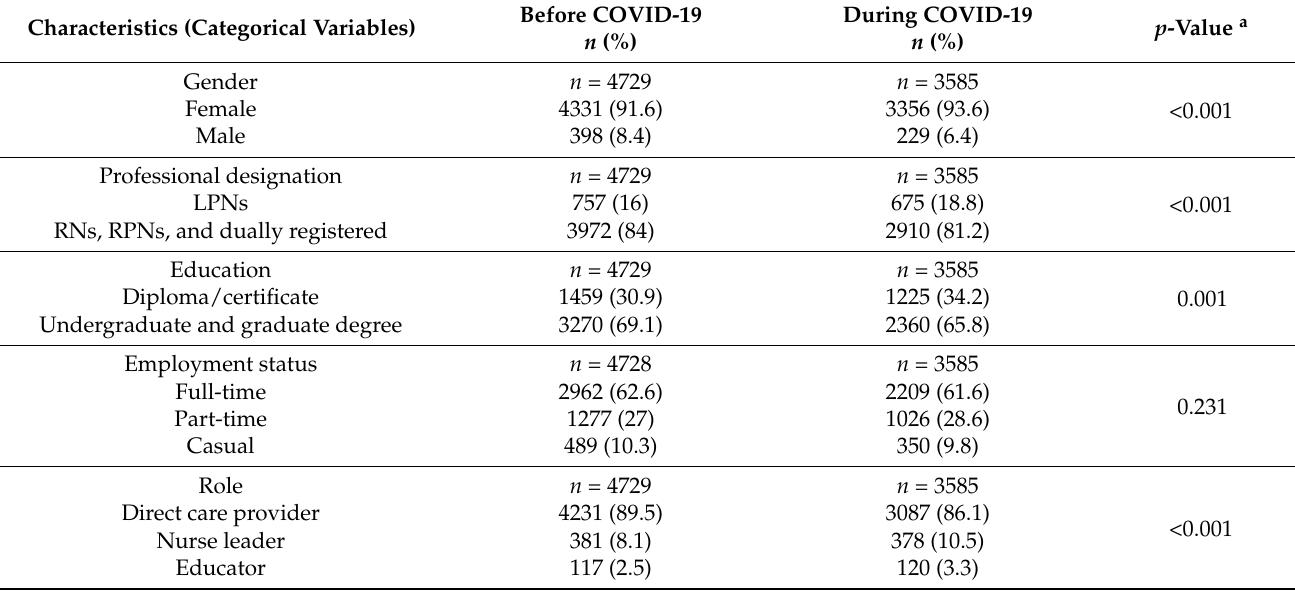
Table 1. Sample demographics before and during